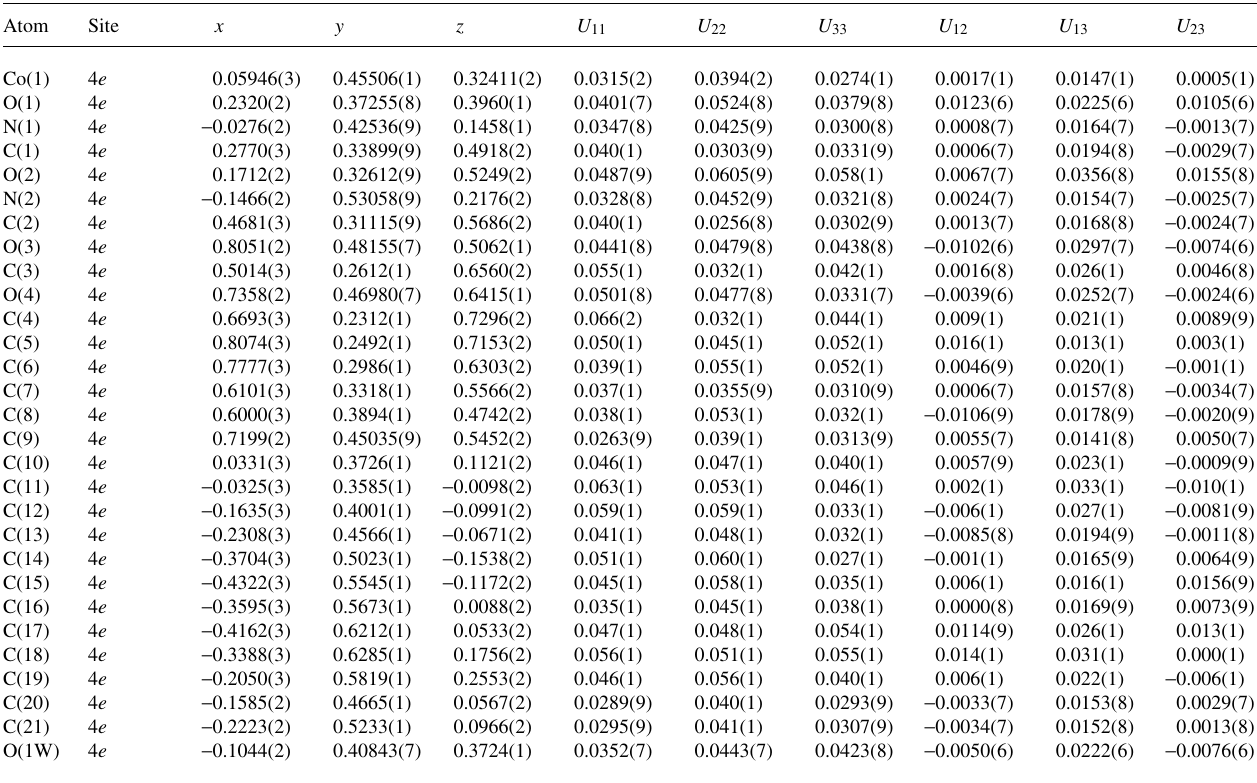
Table 3. Atomic coordinates and displacement parameters (in Å 2 )